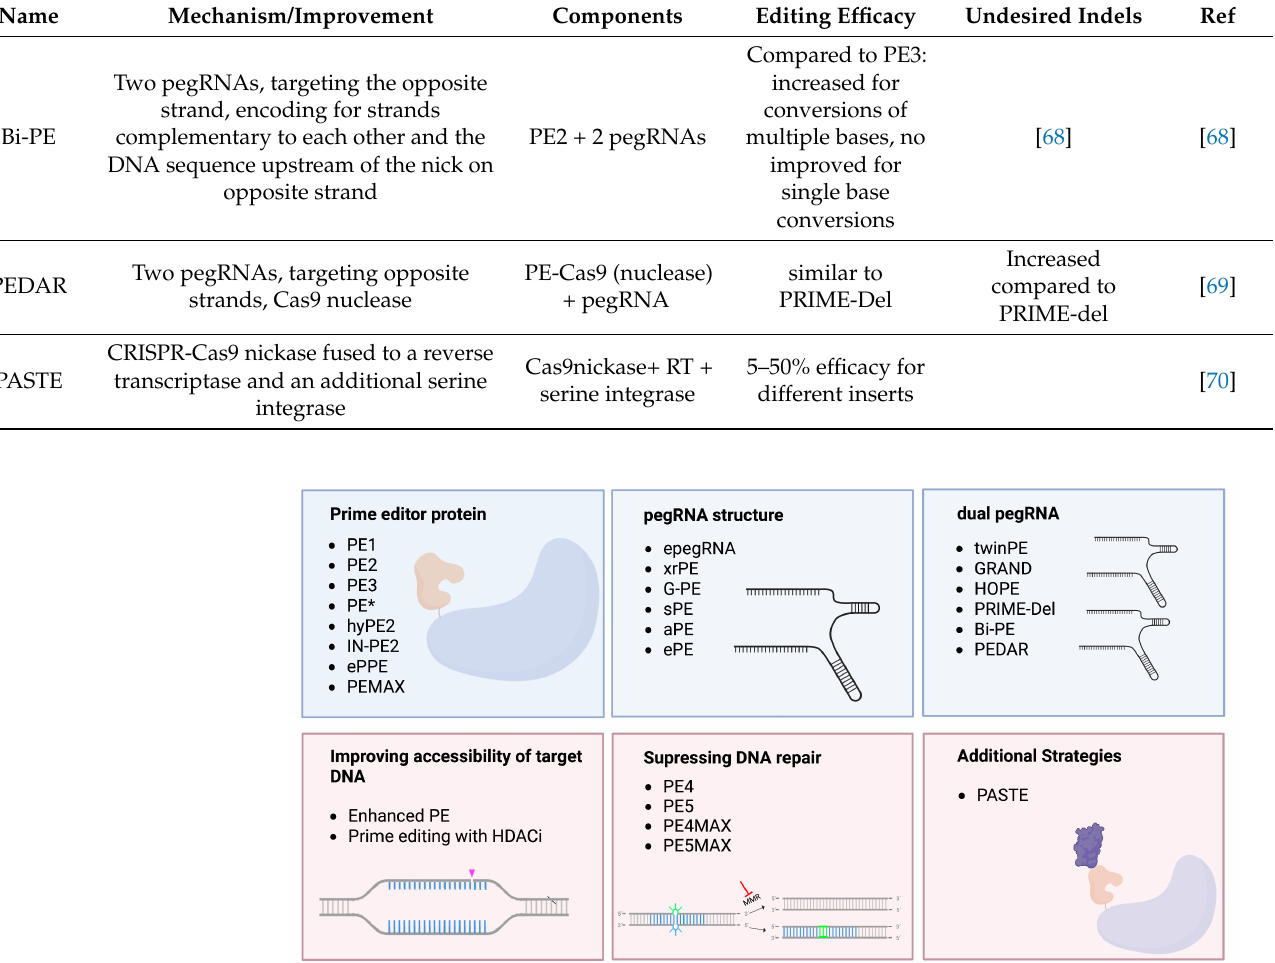
Figure 3. Graphical overview of the development and improvements of the Prime editing technology. Improvements affecting the PE:pegRNA complex in the upper row (blue), other improvements in lower row